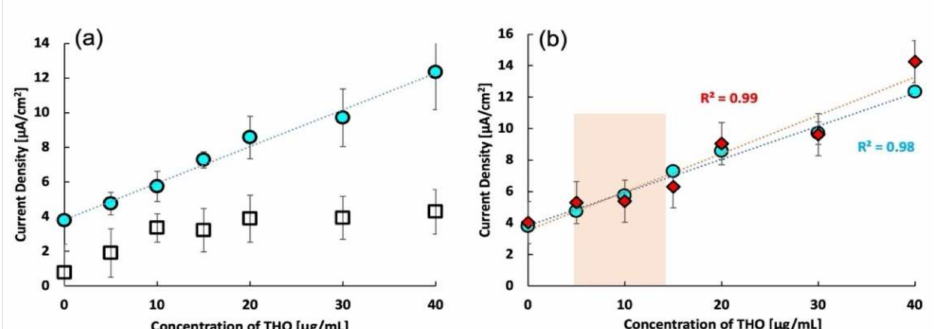
Figure 4. ( a ) Calibration curves of the response of MIP and NIP in buffer saline solution, ( b ) compari- son of calibration curves of MIP response to theophylline in buffer saline and whole bovine blood. Circles represent the imprinted polymer response, squares represent the non-imprinted polymer response, and diamonds represent the response of MIP in whole bovine blood.